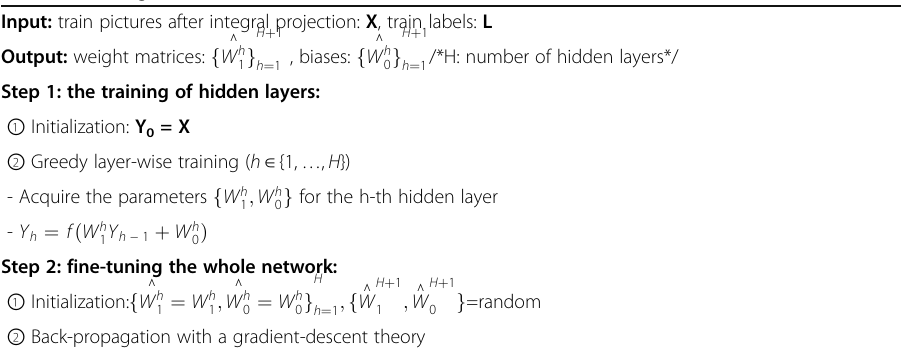
Table 2 The algorithm of a stacked